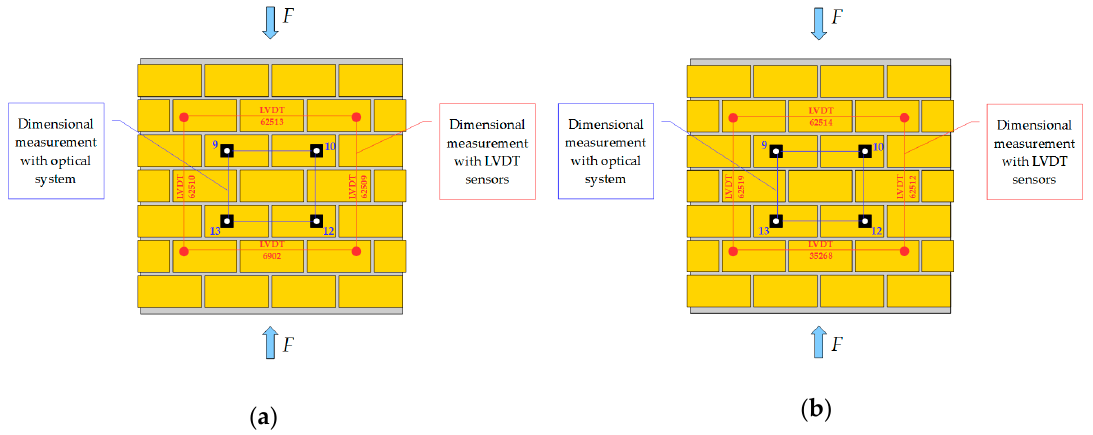
Figure 12. Measurement points in the specimen’s ( a ) frontal surface; ( b ) rear surface.